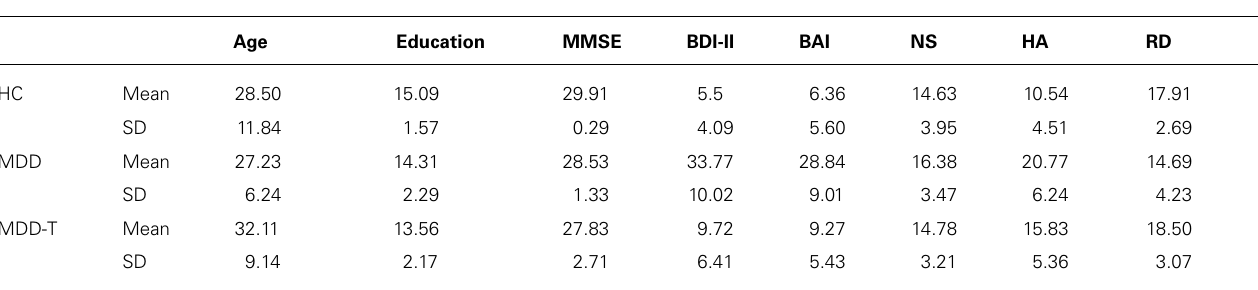
Table 1 | Summary of demographic and neuropsychological